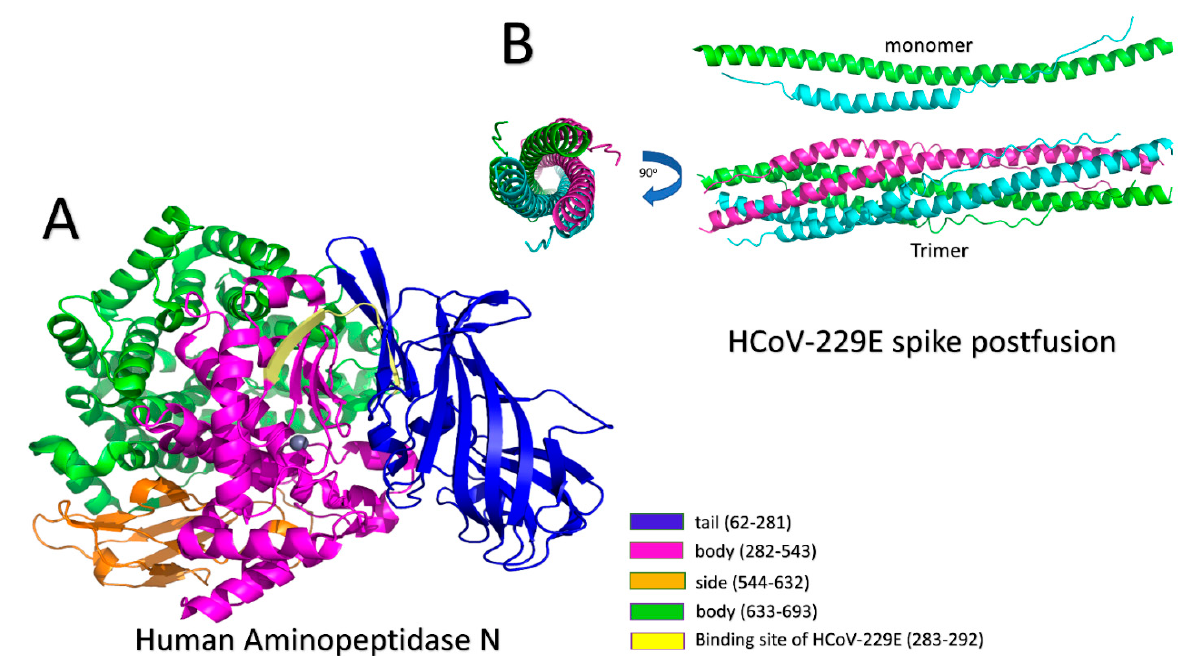
Figure 2. ( A ) Human aminopeptidase N (APN): different parts and the binding site with HCoV-229E (PDB ID: 5LHD). Blue: tail (62–281), pink: body (282–543), orange: side (544–632), green: body (633–693), and yellow: binding site of HCoV-229E (283–292). A Zn +2 ion is in the middle. ( B ) A monomer of the postfusion core structure of HCoV-229E (top). HR1 (green cartoon) consists of 24 alpha helices. HR2 (cyan cartoon) contains two conformations, including 9 alpha helices (from amino acid 1067 to amino acid 1098) and extended conformation in both cases. The postfusion core (trimer) structure of HCoV-229E (bottom) is shown from side and top views with 90° rotation angle.